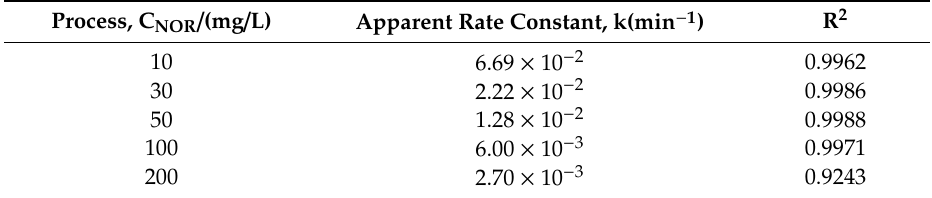
Table 4. The kinetic parameters of NOR degradation at di ff erent initial NOR concentrations.